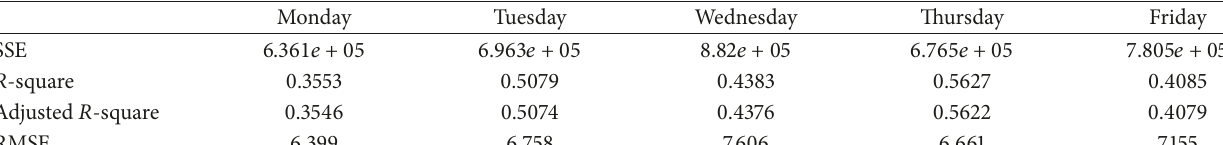
Table 2: Goodness-of-fit test.